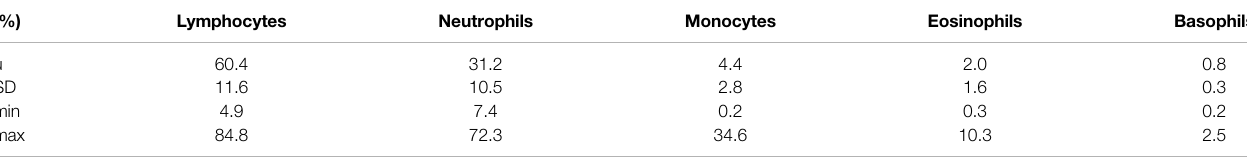
TABLE 2 | Proportion (%) of each nucleated cell type among the total white blood cells. (%)